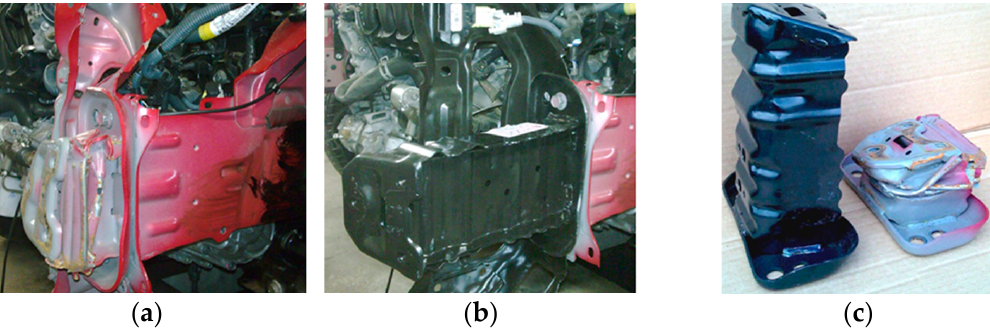
Figure 15. Toyota Yaris crumple zones: deformed after crash ( a ) , recovered after crash ( b ) , crumple zone elements for energy absorption ( c ).